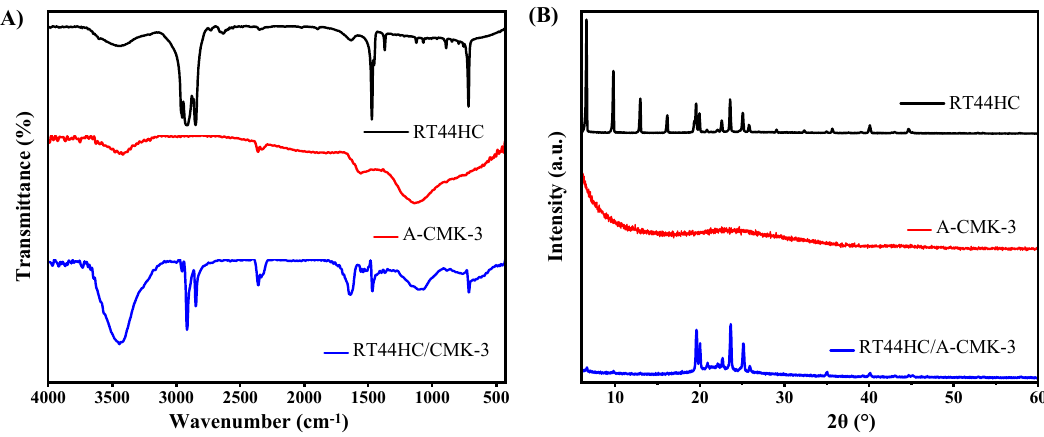
Figure 6. FT-IR spectrum ( A ) and XRD pattern ( B ) of A-CMK-3 based PCM.